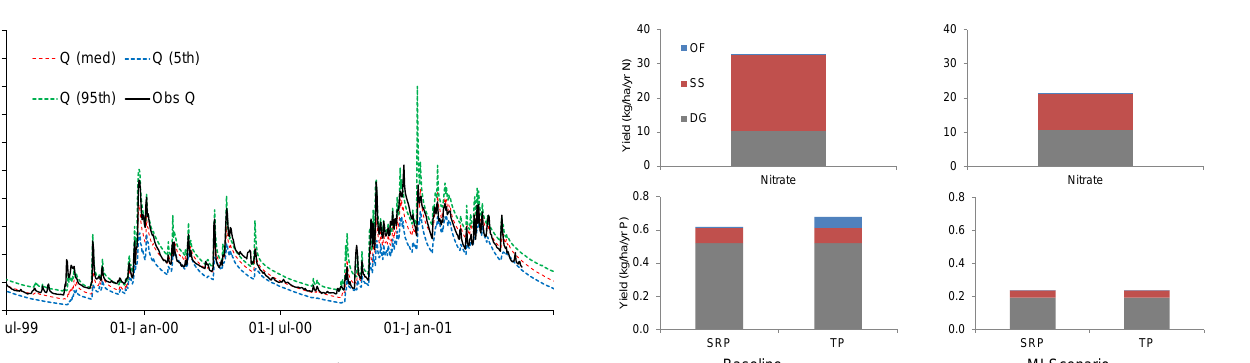
Figure 6. Time series plot of modelled (using Monte Carlo sam- pling to determine parameter values) 5th and 95th percentile and median flows, as well as the observed flows.